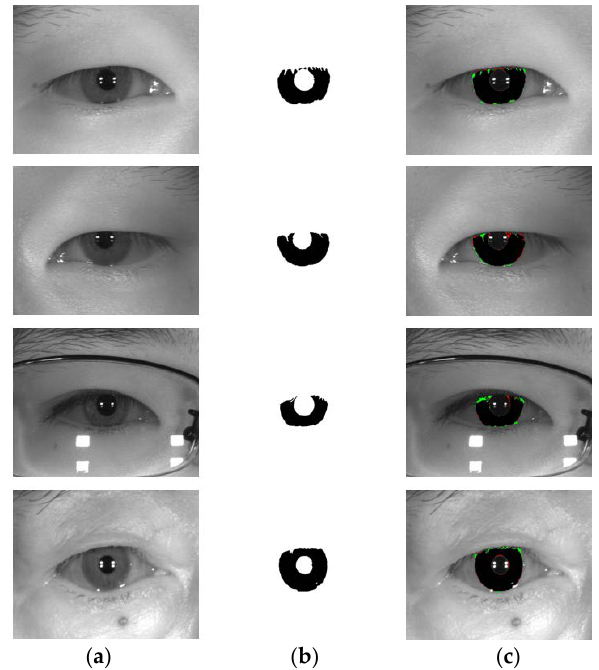
Figure 16. Examples of correct segmentation results in CASIA v4.0 distance database by the proposed method. ( a ) Original image ( b ) Ground-truth image. ( c ) Segmentation result by IrisDenseNet (The false positive and negative errors are presented as green and red, respectively. The true positive case is presented as black).